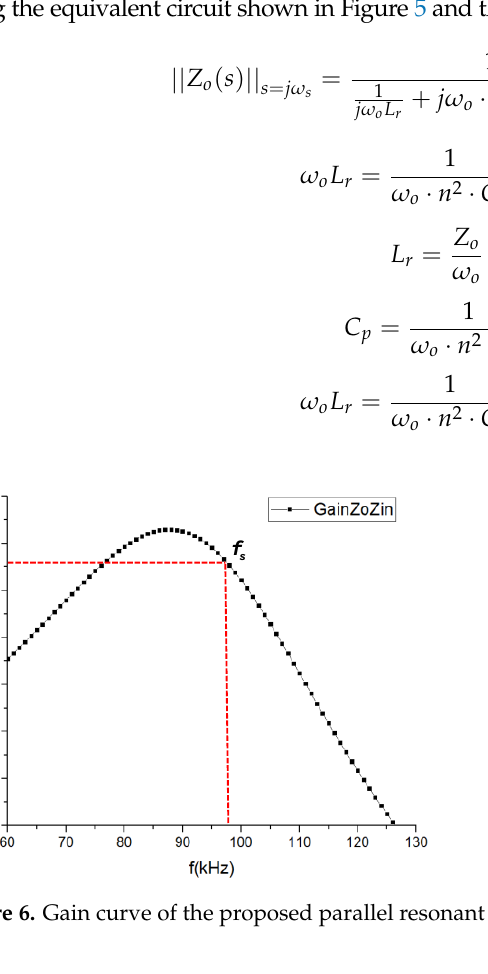
( c ) Figure 7. ( a ) Voltage at the secondary side of the transformer. ( b ) Voltage after 1st voltage multiplier. ( c ) Voltage after 4th voltage multiplier.